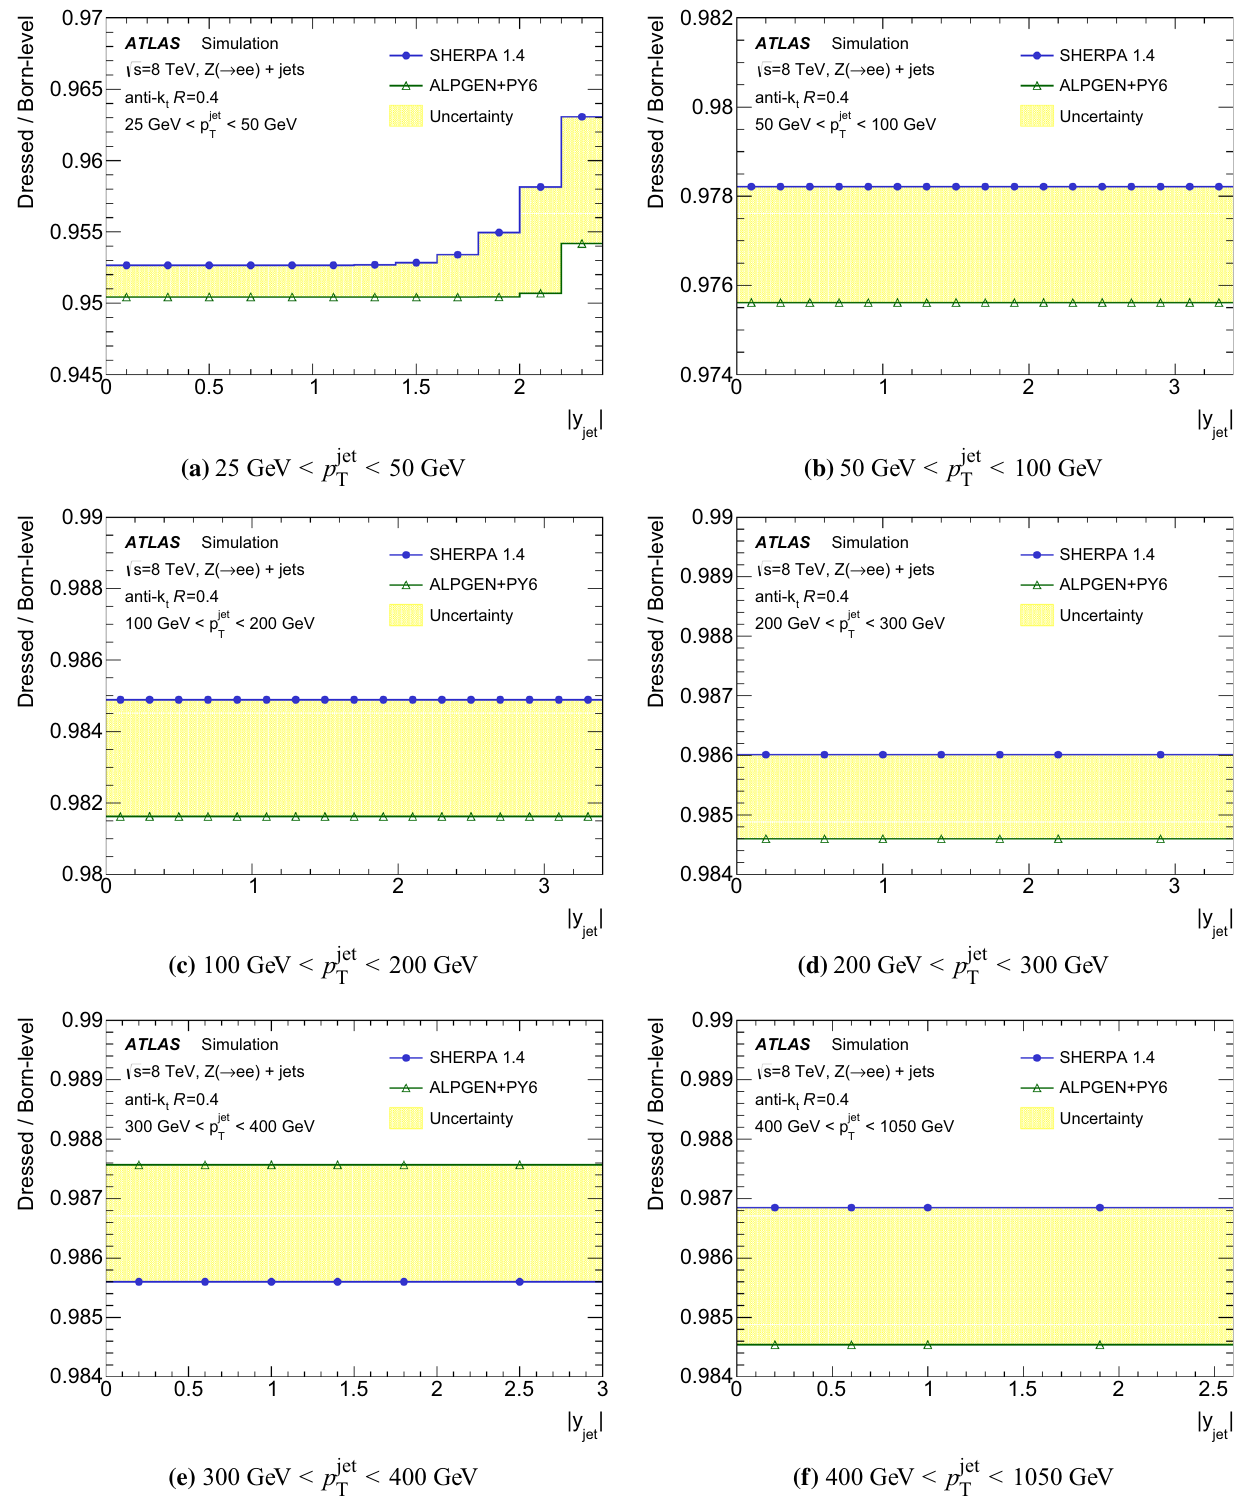
Fig. 4 The correction for QED radiation effects for the Z + jets production cross-section as a function of | y jet | in p jet represents the